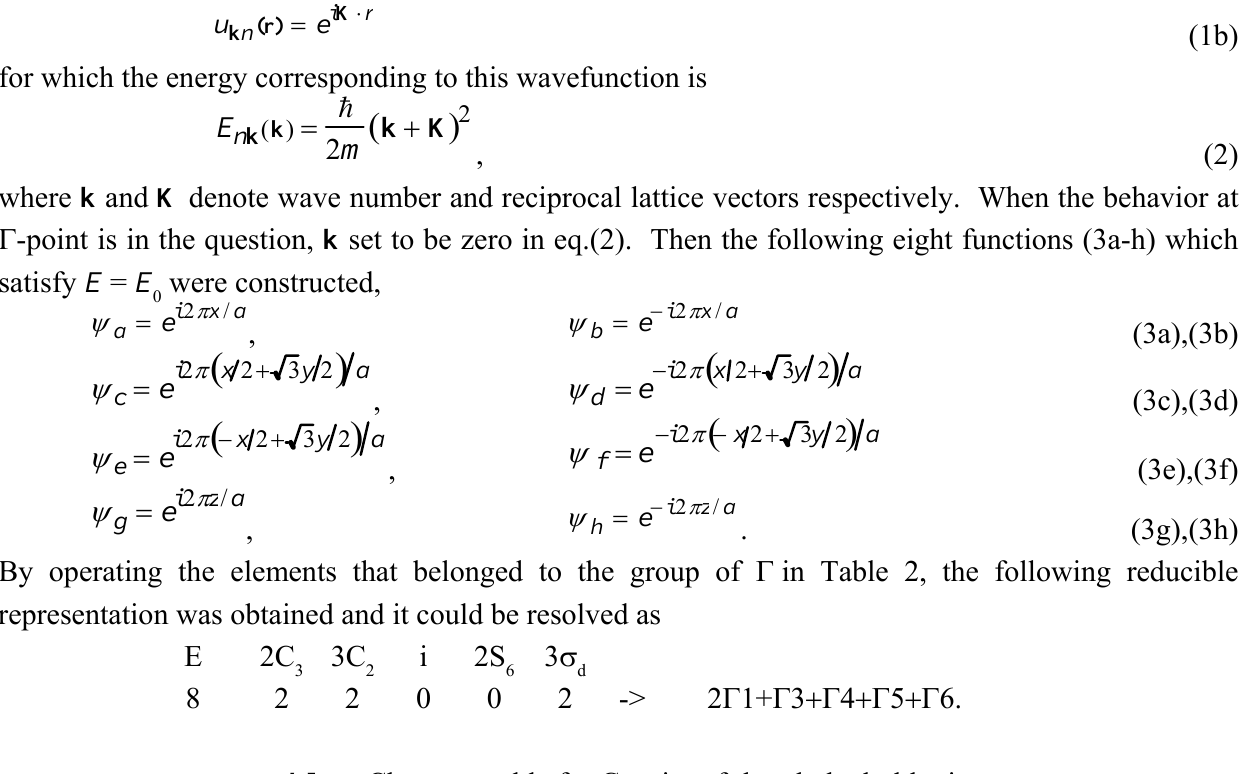
Table 2 . Character table for G-point of rhombohedral